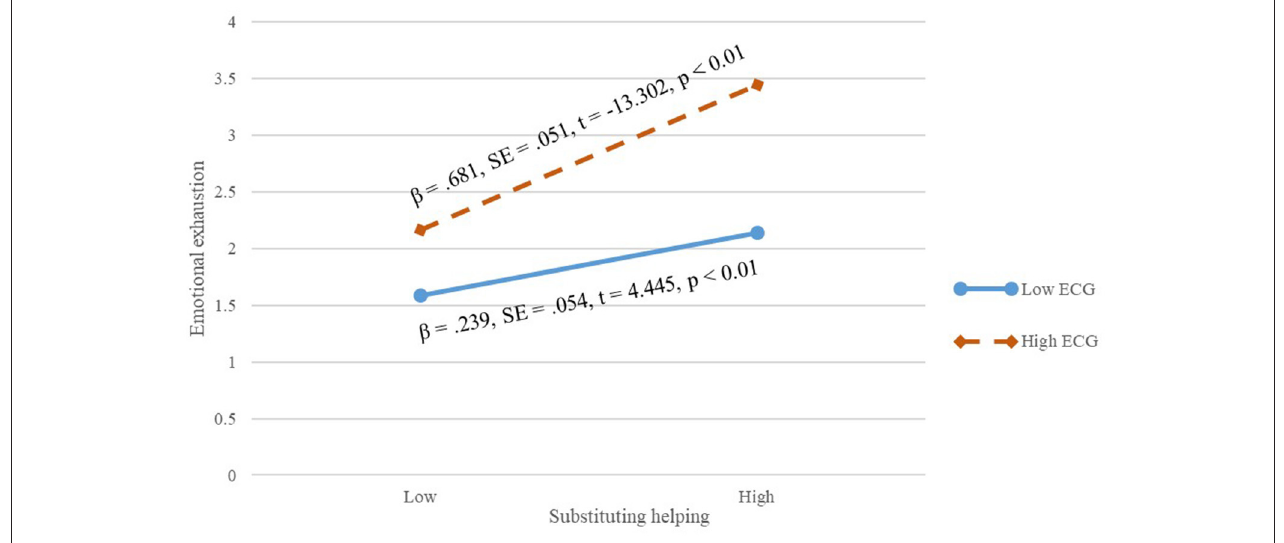
FIGURE 4 | Interactive effect of extrinsic career goals on the relationship between substituting helping and employees’ emotional exhaustion.